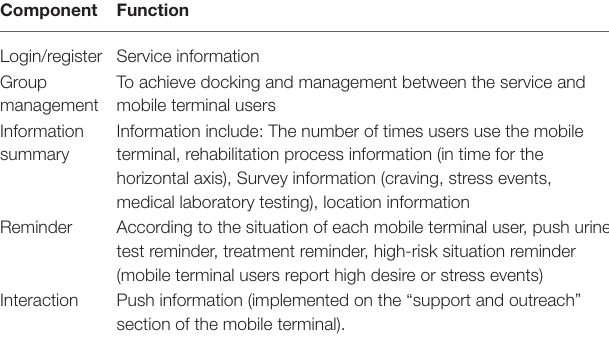
TABLE 2 | Corresponding function of each component of the service provider terminal of the community-based addiction rehabilitation electronic system(CAREs).